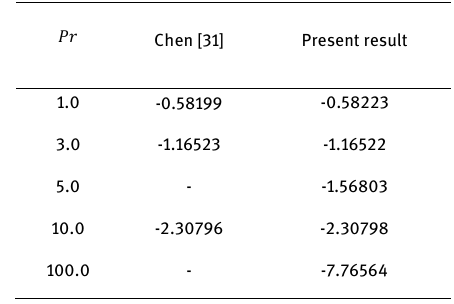
Table 2: Comparison of − θ ′ (0) for different values of Prandtl